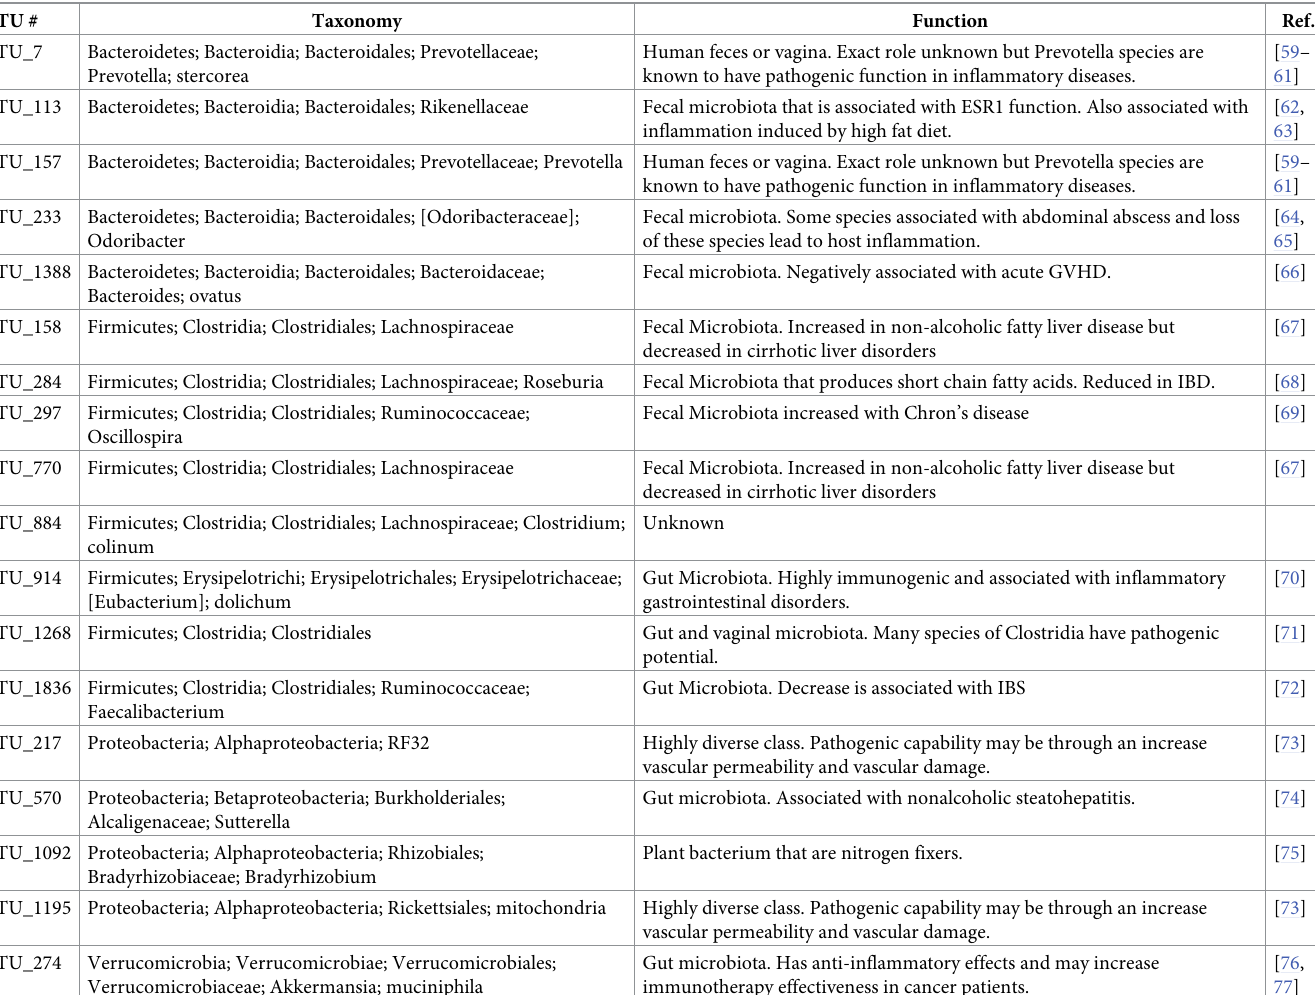
Table 2. List of the top 18 microbial features highly specific to OC pathology. OTU # Taxonomy Function